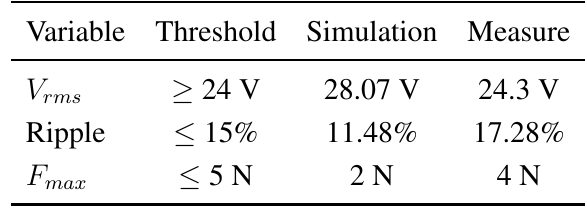
Table 2. Prototype resulting performances.